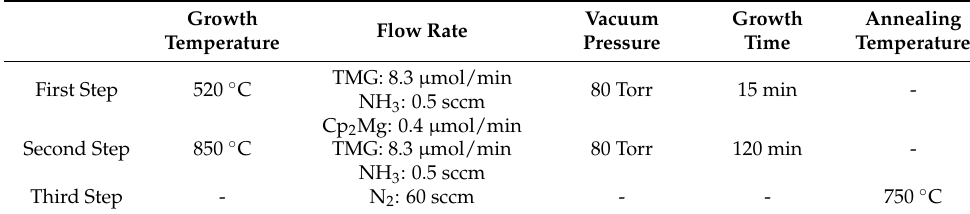
Table 1. The growth parameters of the Mg doped GaN thin